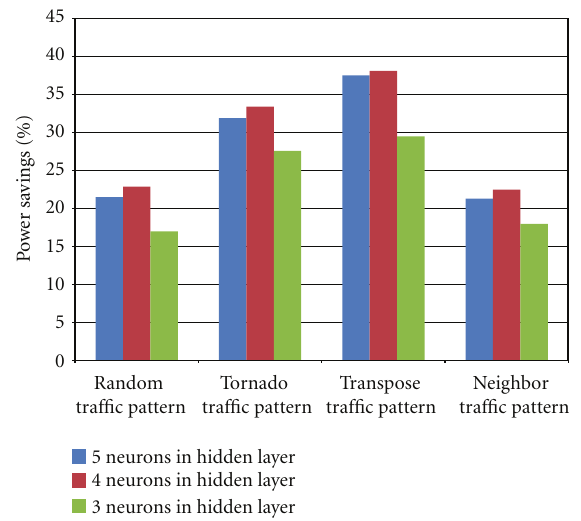
Figure 7: Power savings for five, four and three neurons in the hidden layer of the